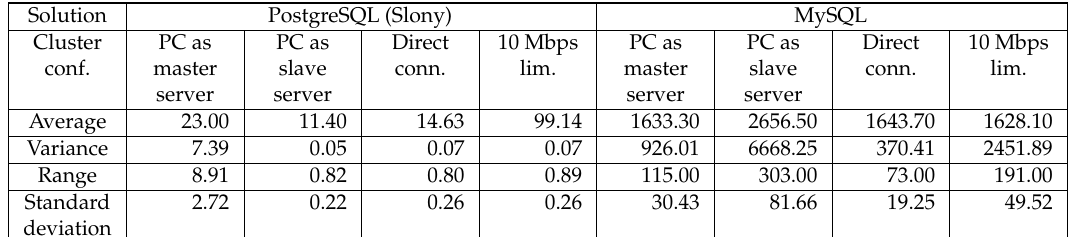
Table 4. Statistics analyses of the replication time of the EPEU layer for both replication